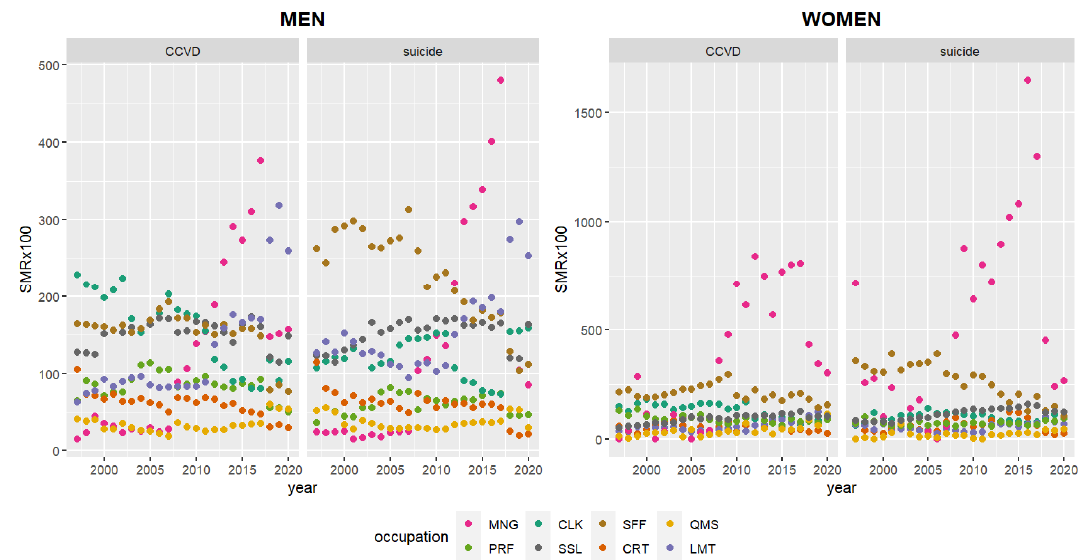
Figure 1. Annual indirect standardized mortality ratio (SMR) of suicide and CCVD in 1997–2020. CCVD—cerebro-cardiovascular disease; MNG—managers; PRF—professionals and related workers; CLK—clerks; SSL—service and sales workers; SSF—skilled agricultural, forestry, and fishery workers; CRT—craft and related trade workers; QMS—equipment, machine operating, and assembling workers; LMT—elementary workers.